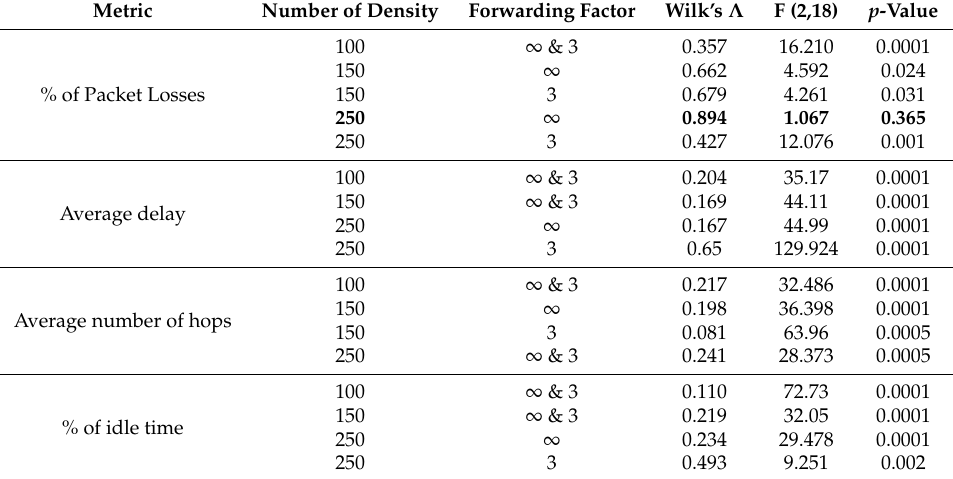
Table 6. MANOVA [37] results of the testing difference in performance metrics among routing recovery techniques ( RT ). There is a significant difference when the p- value <